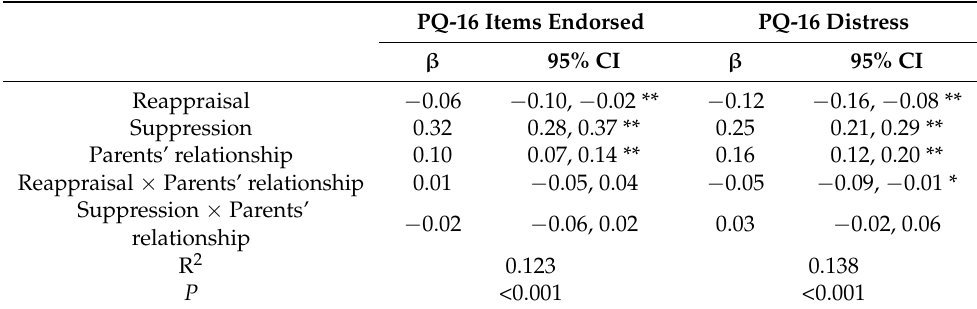
Table 2. Regression for psychotic-like experiences (PLEs) on emotion-regulation strategies, parents’ relationships, and their interaction